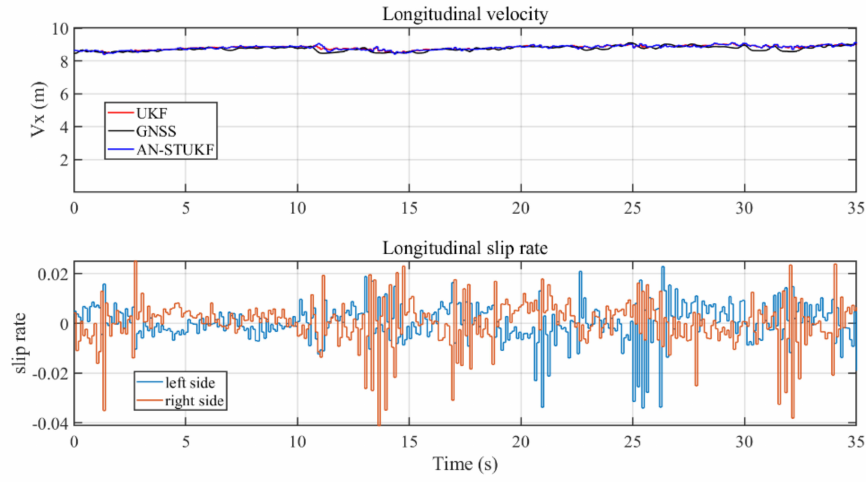
Figure 16. The longitudinal state when a skid-steered wheeled vehicle turns in a large radius.